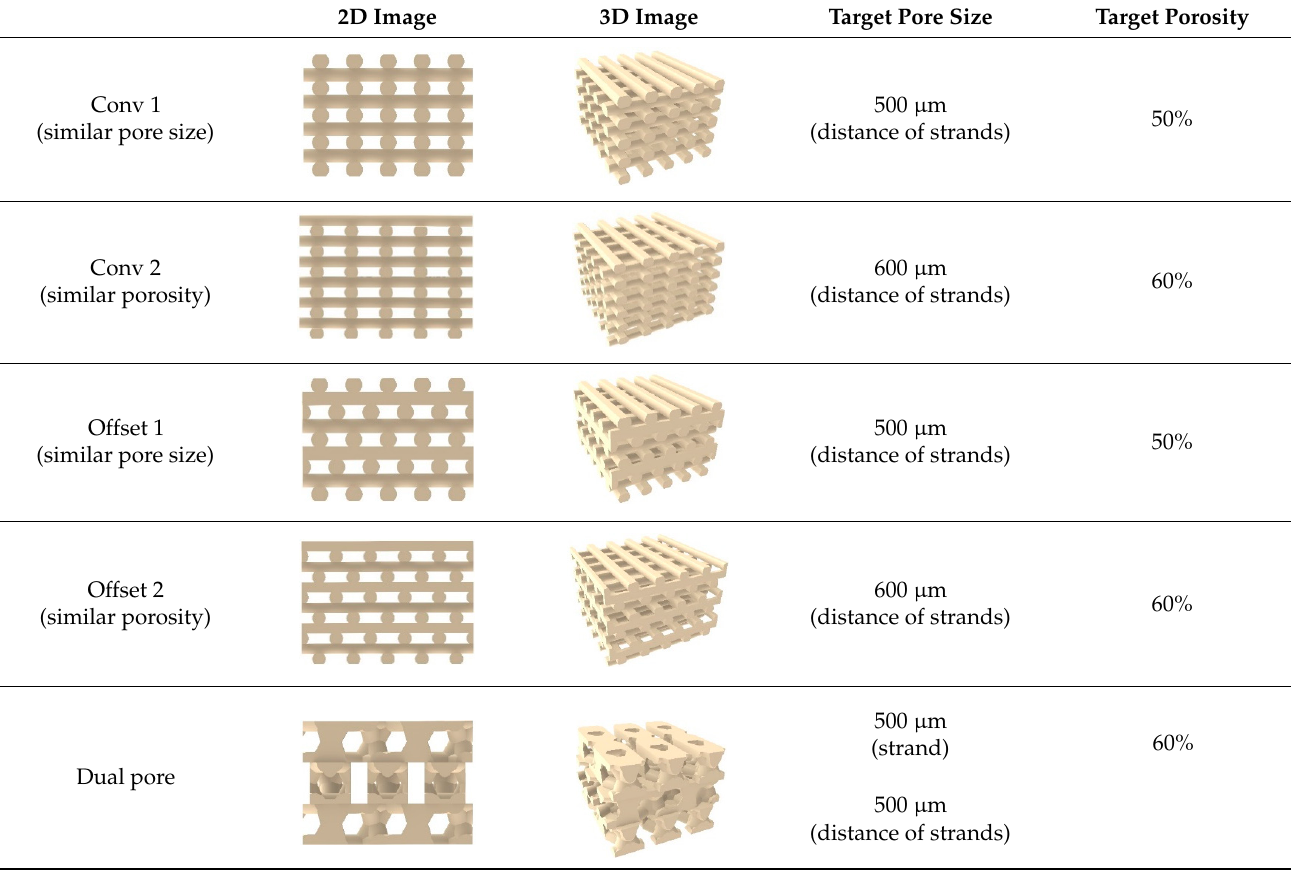
Table 1. Design parameters of the fabricated PCL/nHA scaffolds.